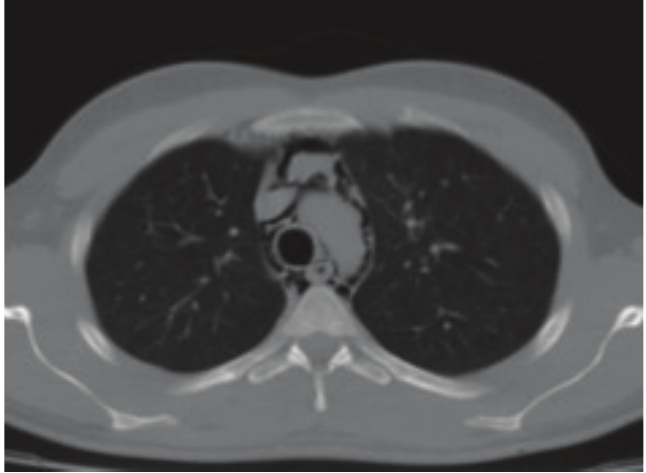
Figure 5 - Diffuse pneumomediastinum on computed tomography (CT) of the third